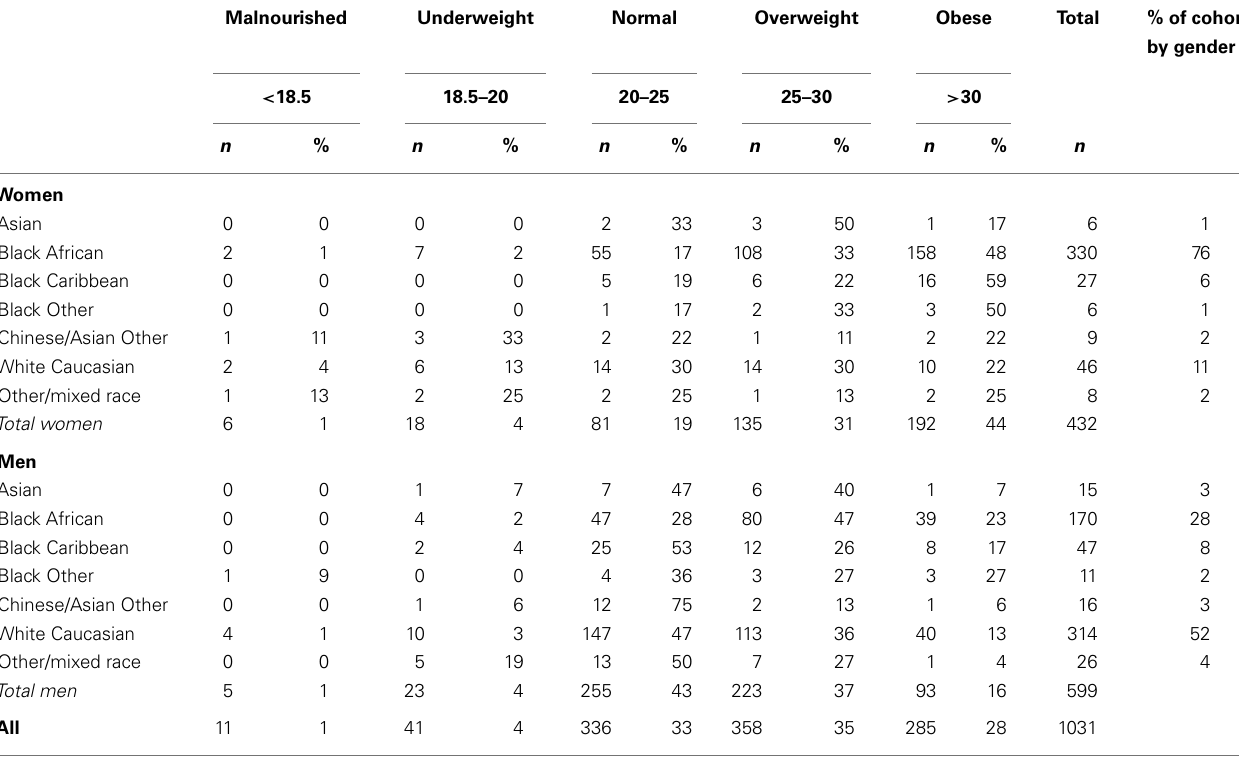
Table 2 | Distribution of BMI groups by gender and race among clinic attenders 2011–2012 . Malnourished Underweight Normal